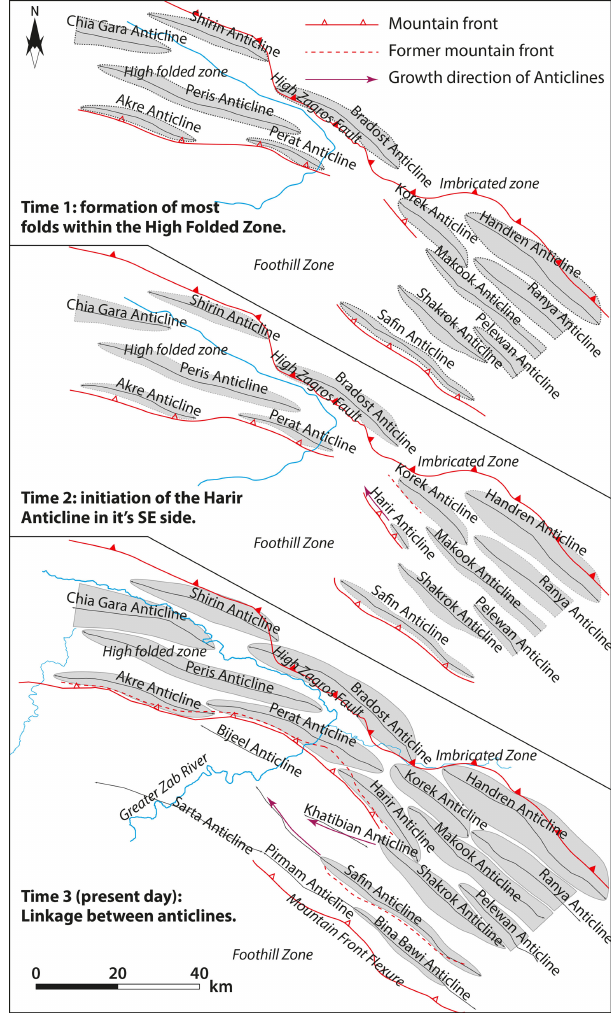
Figure 14. Simplified history of the formation of anticlines during the propagation of the deformation front over time in the study area. The Harir anticline is likely the latest to have formed within the High Folded Zone in its SE end. It occupies the position of a relay structure during the linkage of two adjacent, but overlapping, seg- ments of the deformation front. The anticlines were outlined based on the exposure of Cretaceous